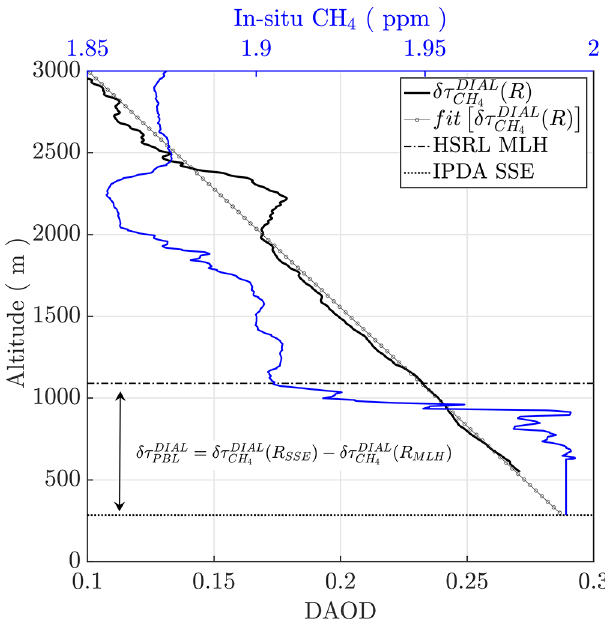
Figure 19. Range-resolved DAOD at 350m vertical by 12.5km along-track resolutions, black, with fitted estimate overlaid, grey, with extrapolation to the SSE. The HSRL MLH and IPDA SSE are shown for the overpass region and allow an estimate of δτ DIAL the fitted profile. The in situ CH 4 profile from the subsequent spiral profile, blue, is shown for